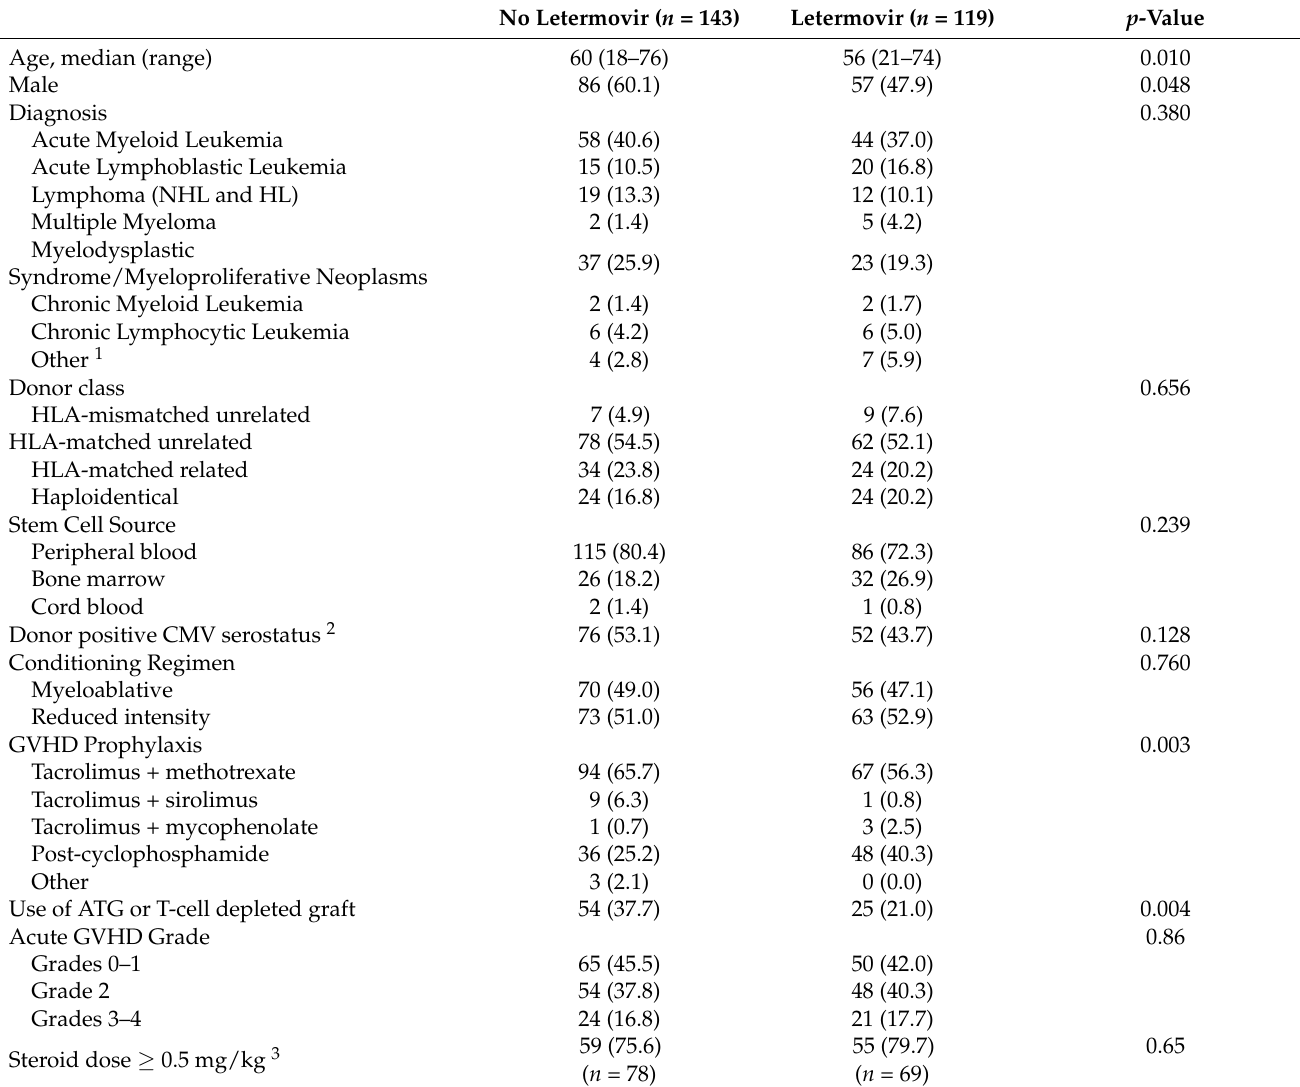
Table 1. Baseline